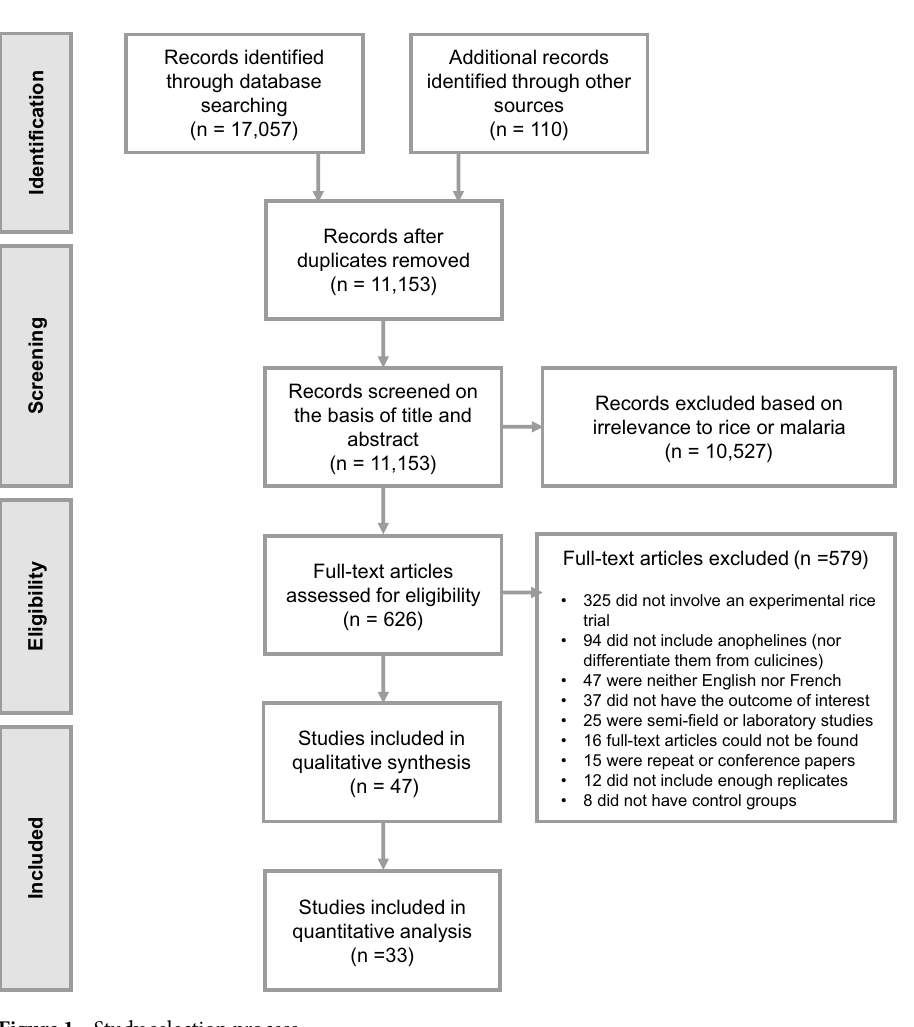
Figure 1. Study selection